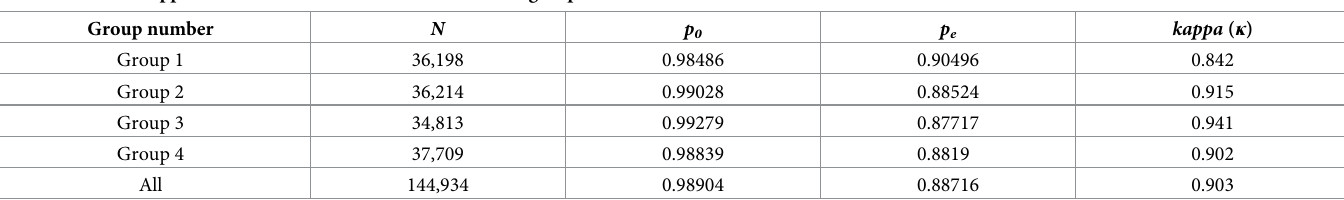
Table 7. Cohen’s kappa values for the annotation results of each group.